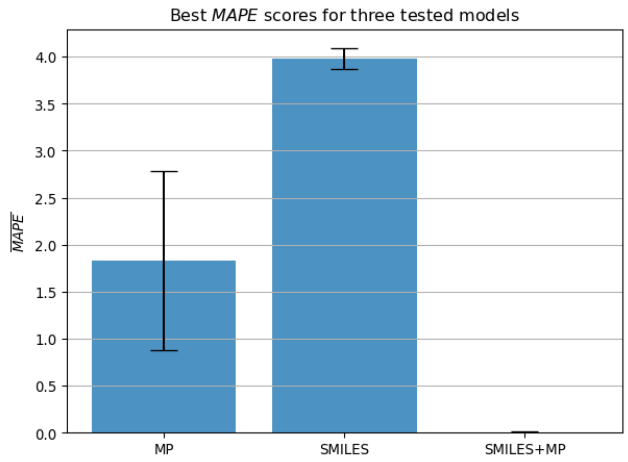
Figure 8. The best results achieved with each of the neural network configurations, evaluated using MAPE metric (lower is better), expressed as mean across folds and standard error (MP—molecular properties, MAPE —mean absolute percentage